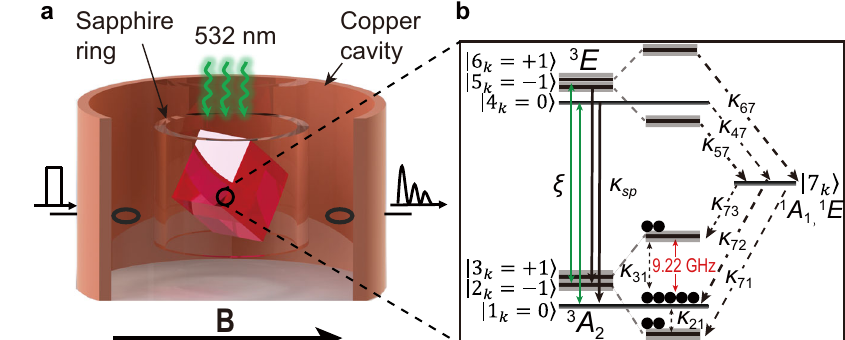
Fig. 1 Proposed system and energy diagram. a Setup modi fi ed from the diamond maser experiment 16 with nitrogen-vacancy (NV) centers in diamond excited by a 532 nm laser and coupled to a single-crystal sapphire dielectric ring microwave resonator inside a copper cylindrical cavity in the presence of a magnetic fi eld, where the resonator is driven by a microwave fi eld and the transmitted signal is measured. b Downward and upward Zeeman shift of the spin levels with projections − 1 and + 1, and the processes involving the multiple electronic and spin levels of the NV centers: optical excitation and stimulated emission with rate ξ (green double-headed arrows), spontaneous emission with rate k sp (downward black arrows), inter-system crossing with rates k i 7 , k 7 j (with i = 4, 5, 6 and j = 1, 2, 3, tilted dashed arrows), spin-lattice relaxation with rates k 31 ≈ k 13 , k 21 ≈ k 12 (double-head dashed arrows), and spin-dephasing with rates χ 2 , χ 3 (shaded gray width of energy levels). The thickness of arrows indicates the relative amplitude, and the black spheres show the relative population of the three spin levels on the electronic ground state. The values of various rates are speci fi ed in the Supplementary Table 1, and more details are provided in the main